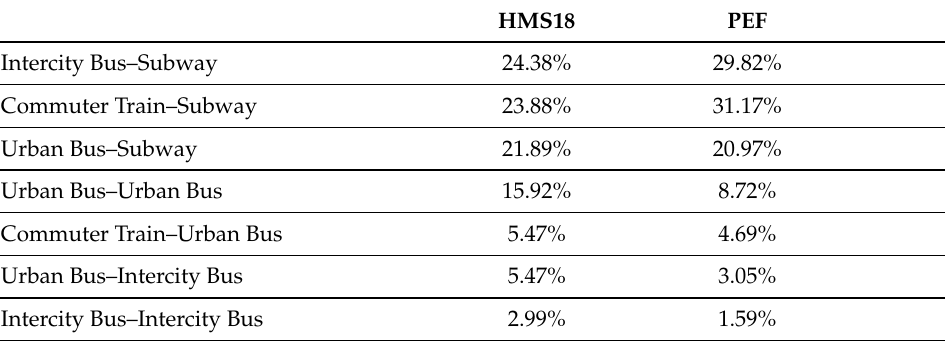
Table 1. Household Mobility Survey and Reverse Pairing